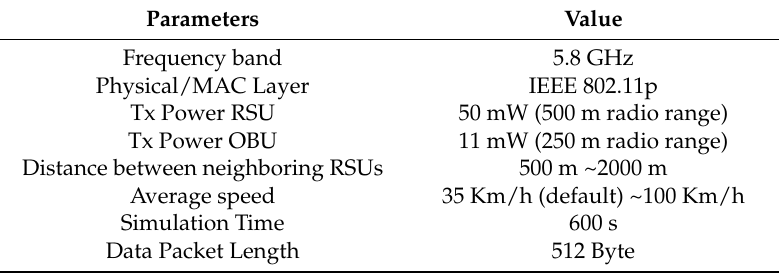
Table 3. Simulation